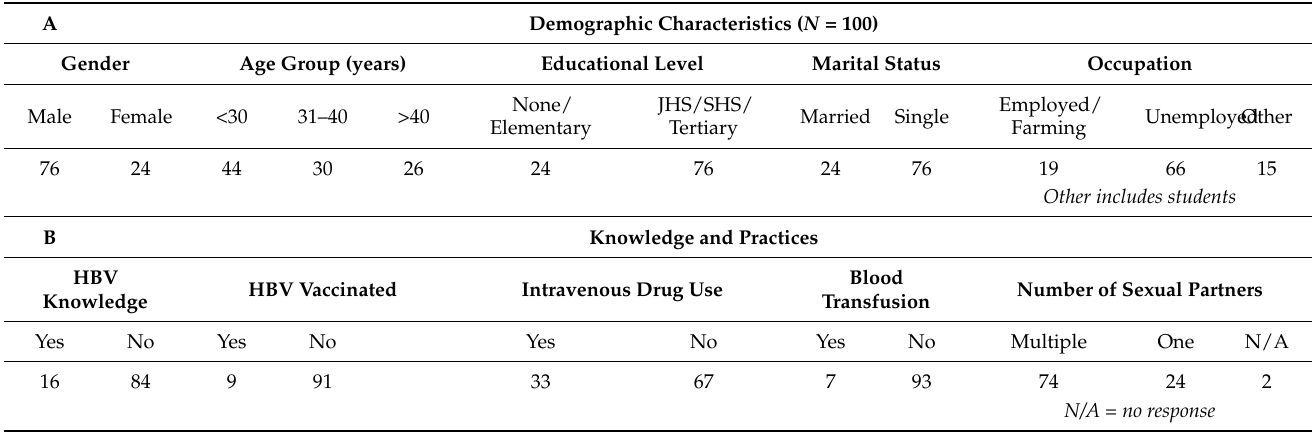
Table 1. Participants’ demographic characteristics, knowledge, and